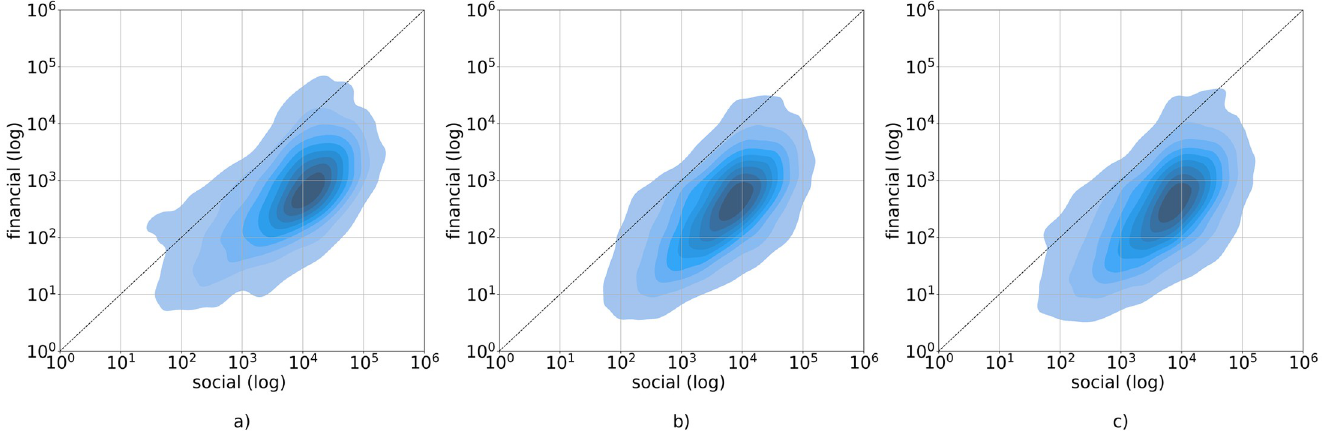
Fig 9. User’s social and financial activity, for each currency. KDE scatter plots relating social and financial activities (number of votes) and creation (number of posts and comments)for each of the three currencies. On the x-axis: social actions. On y-axis: financial actions. Darker colored areas correspond to higher density.